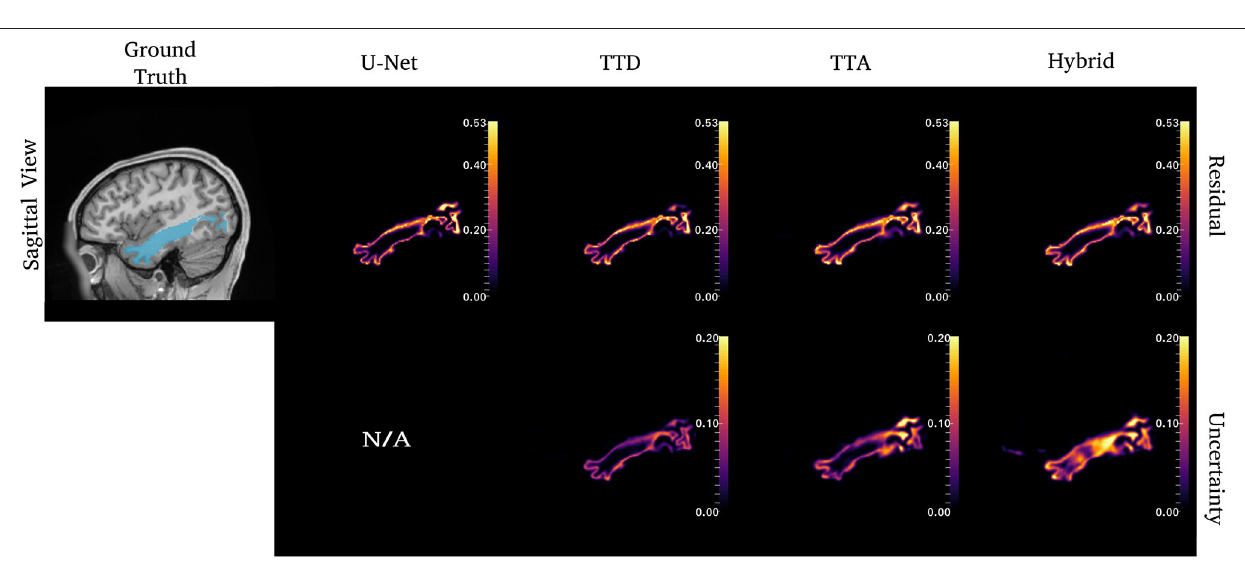
FIGURE 5 | Uncertainty and residual maps for the left ILF tract. Uncertainty maps are not applicable (N/A) for the deterministic U-Net